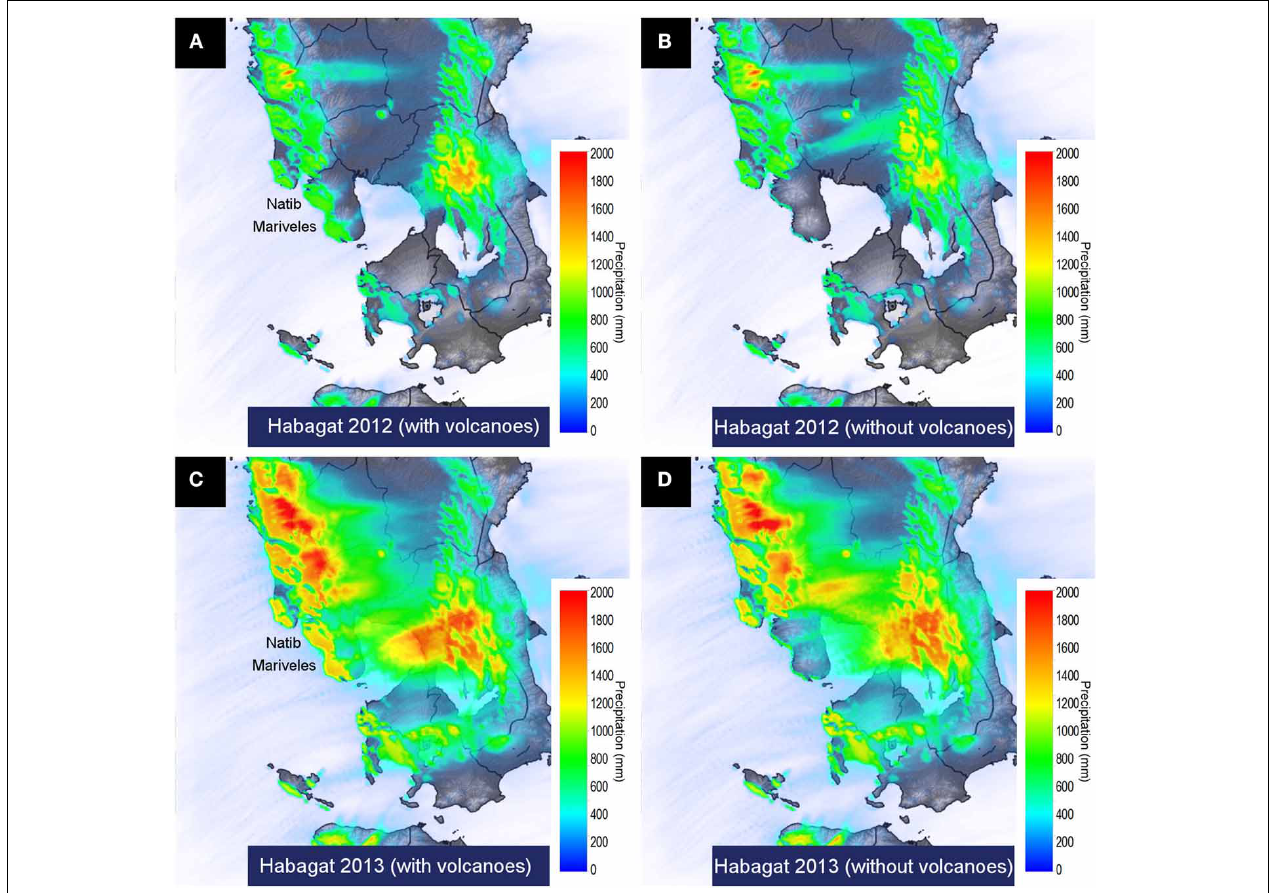
FIGURE 5 | Simulated 1km grid-scale accumulated ground precipitation in Manila bay area from 6 August 0Z to 10 August 0Z 2012 during Habagat 2012 for (A) topography with Natib and Mariveles volcanoes